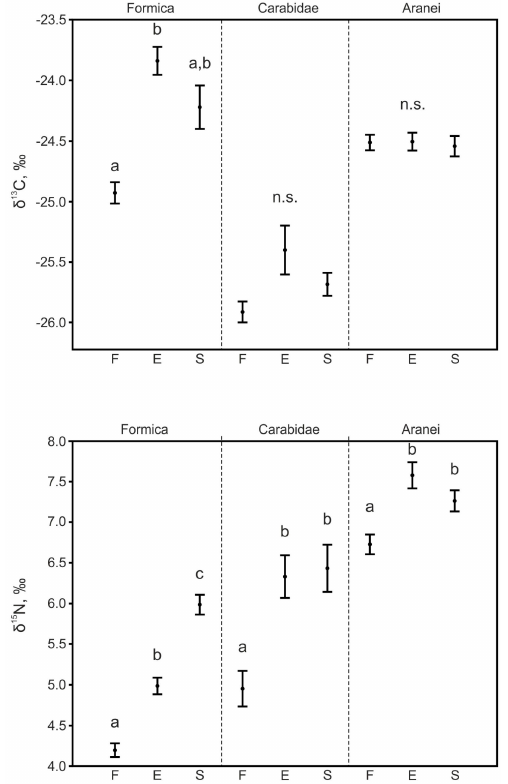
Figure 4. Mean ( ± 1 SE) δ 13 C (top) and δ 15 N (bottom) values of ants, ground beetles, and spiders in the forest, forest edge, and steppe habitats. Significantly ( p < 0.05) different values are indicated by different letters (a, b, c). n.s. – no significance. F: forest, E: edge, S: